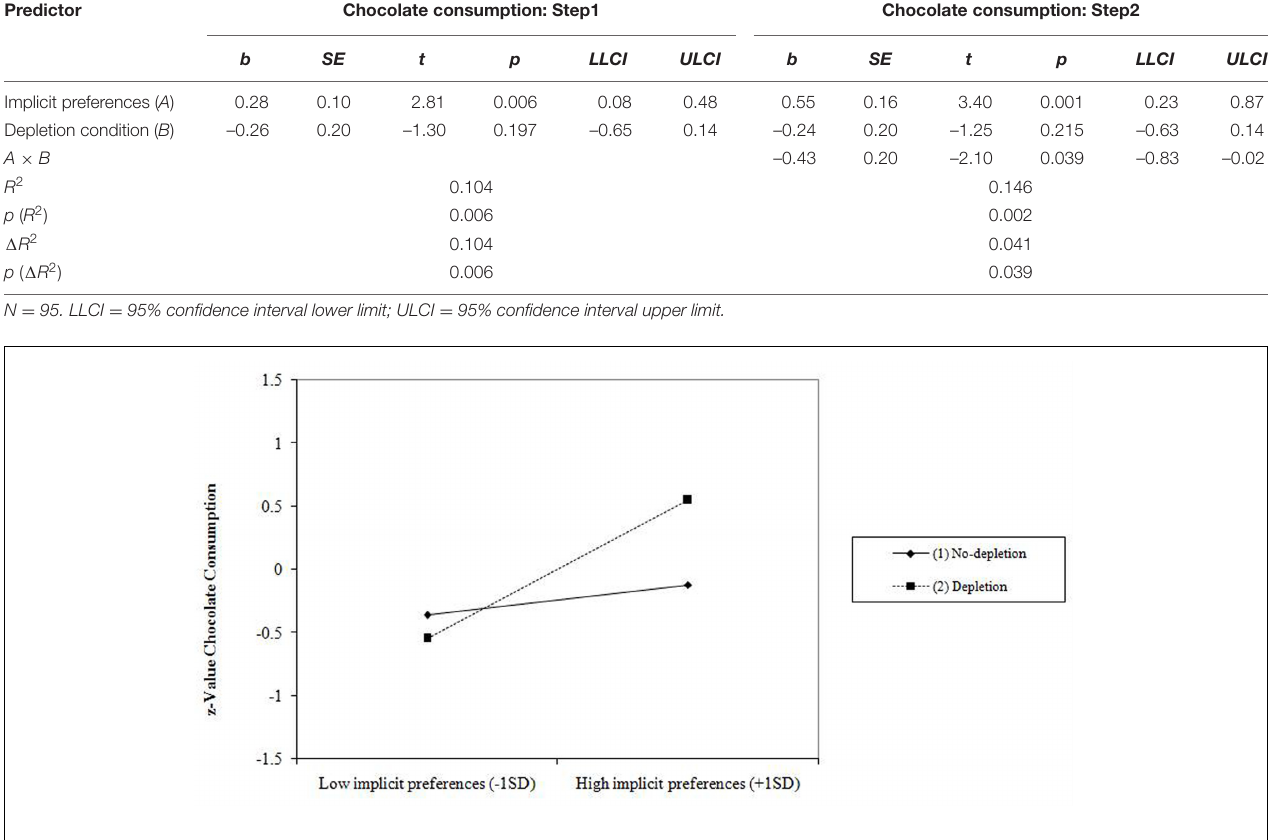
FIGURE 1 | Slopes for implicit preferences-chocolate consumption relationship across levels of ego